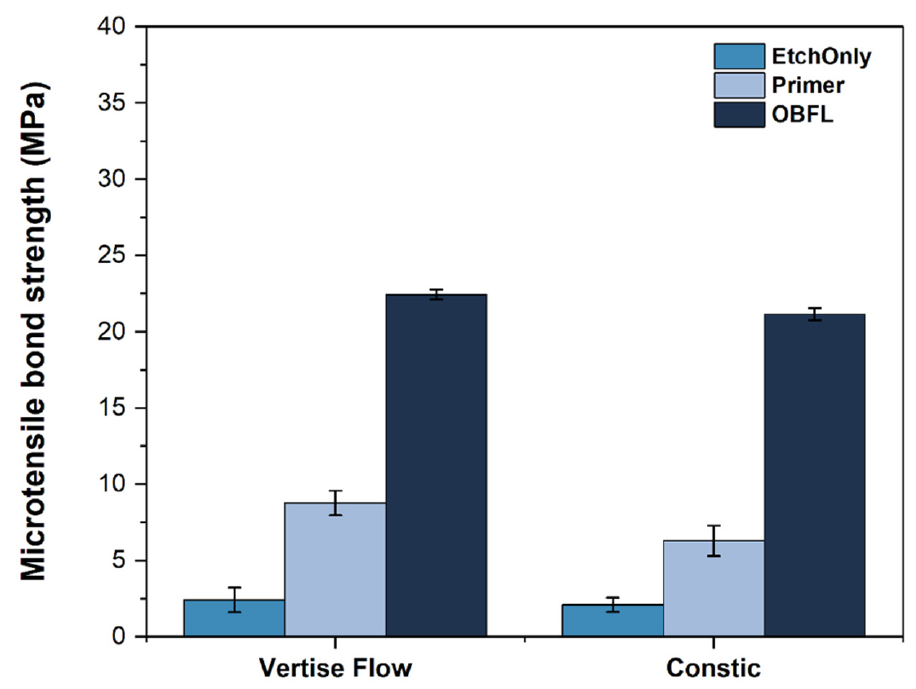
Figure 6. Bar chart comparing different groups in study. Etching dentin, as a stand-alone treatment, revealed the lowest bond strengths, which were significantly different to using a primer by itself and co-curing it together with the self-adhesive composite (Tukey’s HSD, p < 0.05). However, both of the groups were still significantly inferior to using the full etch-and-rinse protocol. Error bars shown are standard errors of means. Table 4. ANOVA two-way output table, showing significance for both variables. Df represents degrees of freedom and